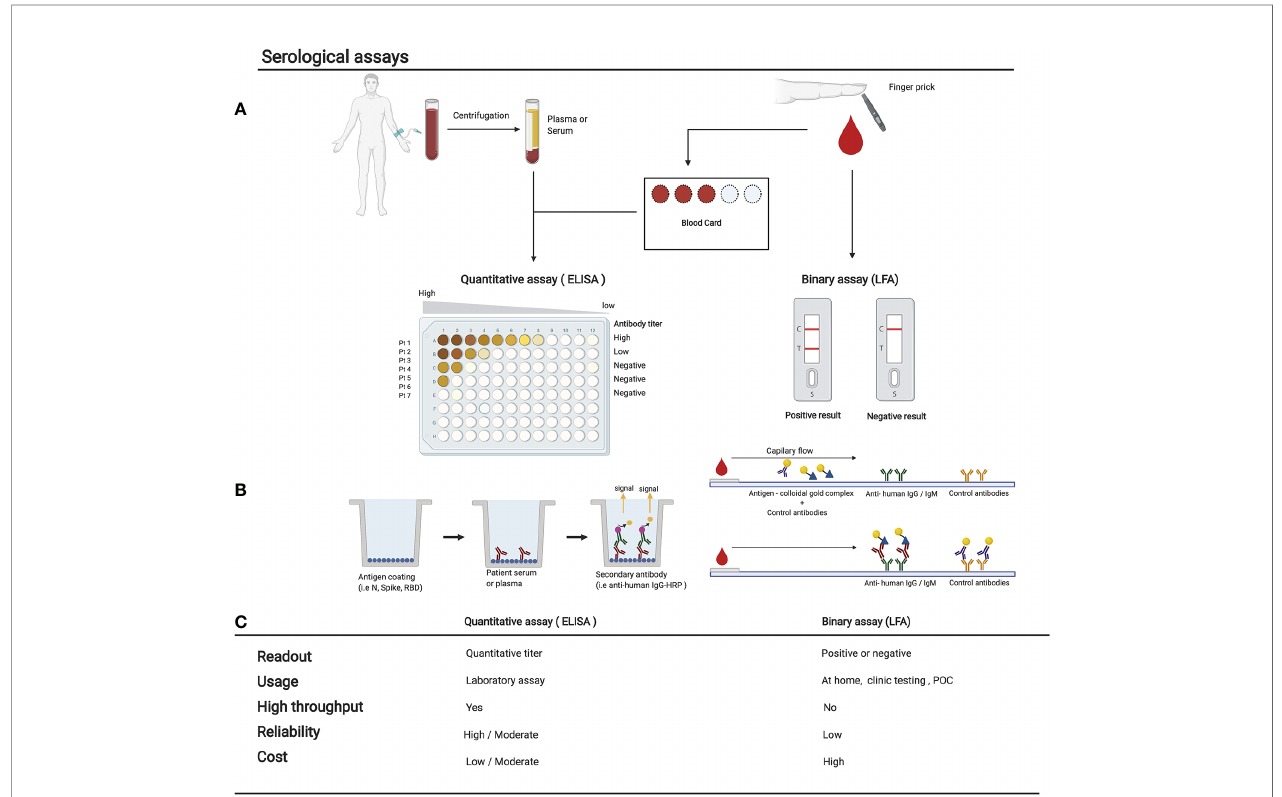
FIGURE 3 | Comparison of various serological assays. (A) The sampling method and subsequent treatment of the blood before performing the serological assay is shown. Either a tube of blood is collected to isolate serum/plasma, or blood from a fi nger prick is used to fi ll a dried blood spot card or used directly in a LFA. Here we show the 2 main types of serological assays: on the left, a quantitative ELISA, or on the right, a binary result LFA. (B) The experimental procedure of each test is shown in their most simple form. Many variations are now available and are being used (see Table S1 ). (C) Comparison of the strengths and weaknesses of each method. POC, point of care; LFA, lateral fl ow assay. Figures were generated using